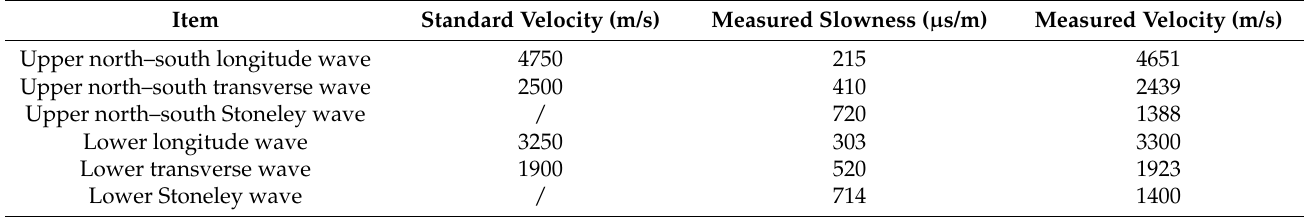
Table 2. Comparison table of standard formation velocity and measured velocity.